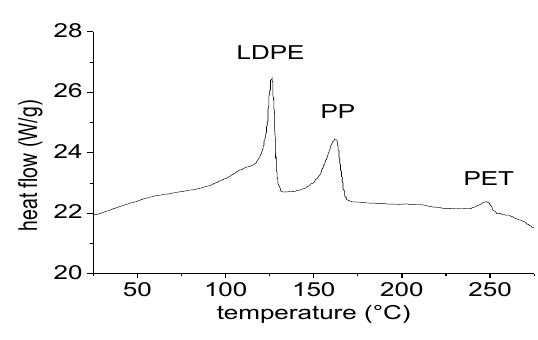
Figure 7. DSC analysis of